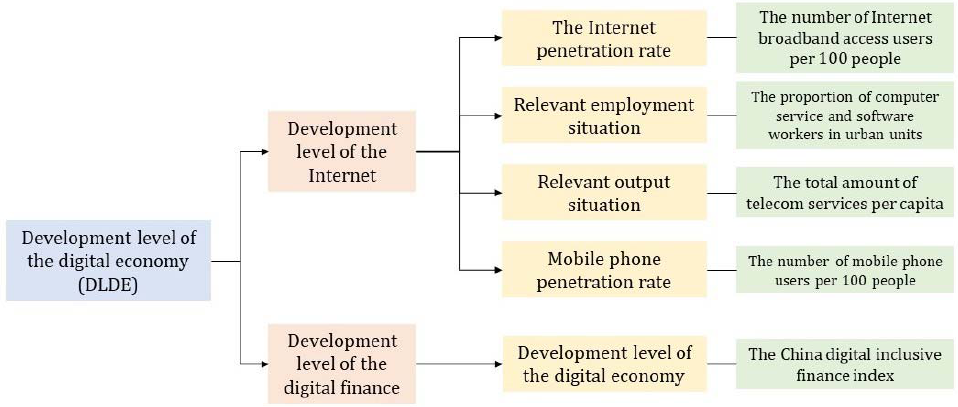
Figure 2. The evaluation index system of DLDE.